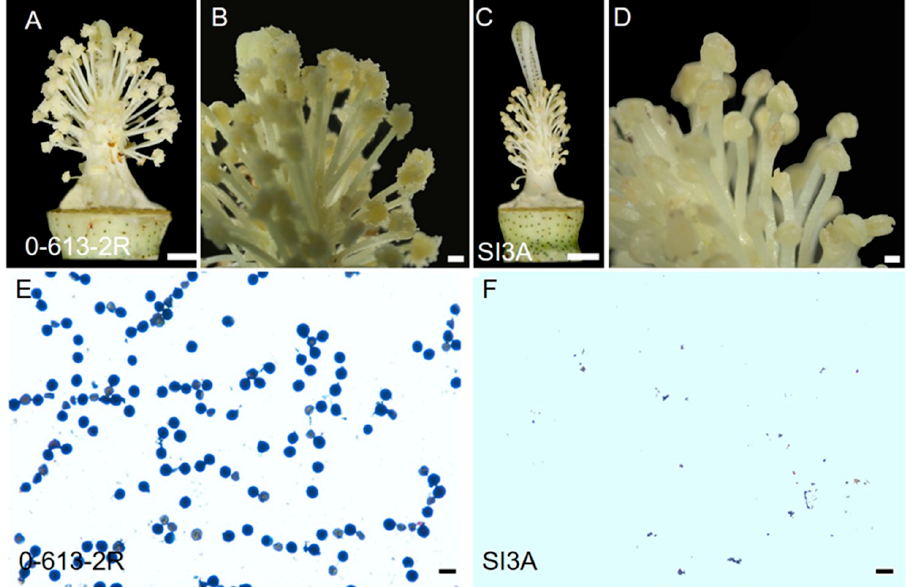
Figure 1. Floral organs morphology and pollen shed of the CMS line, SI3A, and its restorer line, 0-613-2R. ( A , C ), The stamens and pistils of restorer line 0-613-2R (fertile) and CMS line SI3A (sterile). ( B , D ) The enlargement of the anther. ( E , F ) Pollen grains stained with I2-KI. Scale bars correspond to 3 cm ( A , C ), 0.5 cm ( B , D ), and 100 μ m ( E , F ).